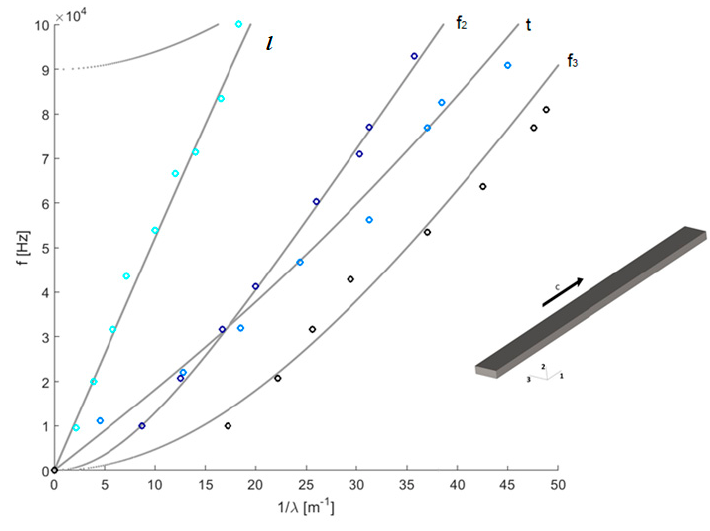
Figure 12. Comparison made between experimental results (dots) and theoretical dispersion curves obtained using SAFE [28] implemented in the COMSOL [29] environment (lines). Moreover, l = longitudinal mode, f 2 = flexion around 2, t = torsion, f 3 = flexion around Axis 3. Notice that, in this plot the wave number is defined as k =(1/ λ) The circle dots in Figure 12 indicate the pairs f and k = 1/ λ found in each test performed. Only one test of each configuration was conducted. However, despite this limitation in the experimental